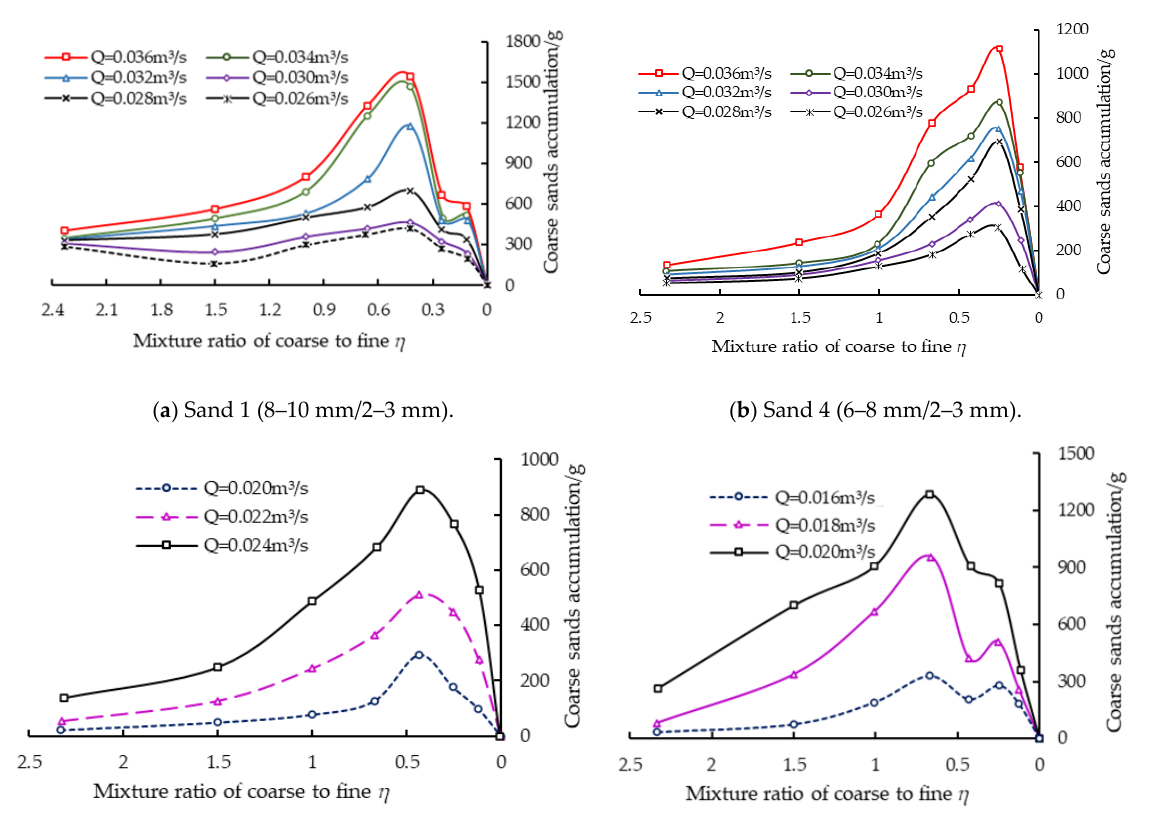
Figure 13. Relationship between the maximum transport rates flow conditions. The changes in the maximum bed load transport rates with the mixture ratio also present a humped curve.